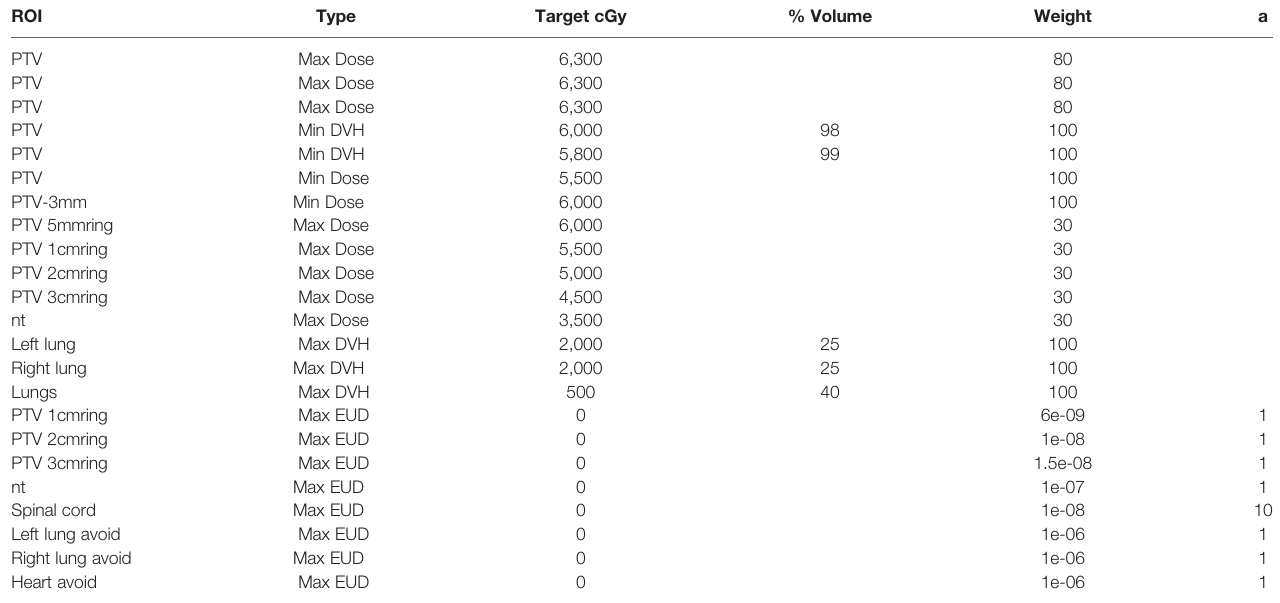
TABLE 4 | Optimization objective template of postmastectomy VMAT plans.